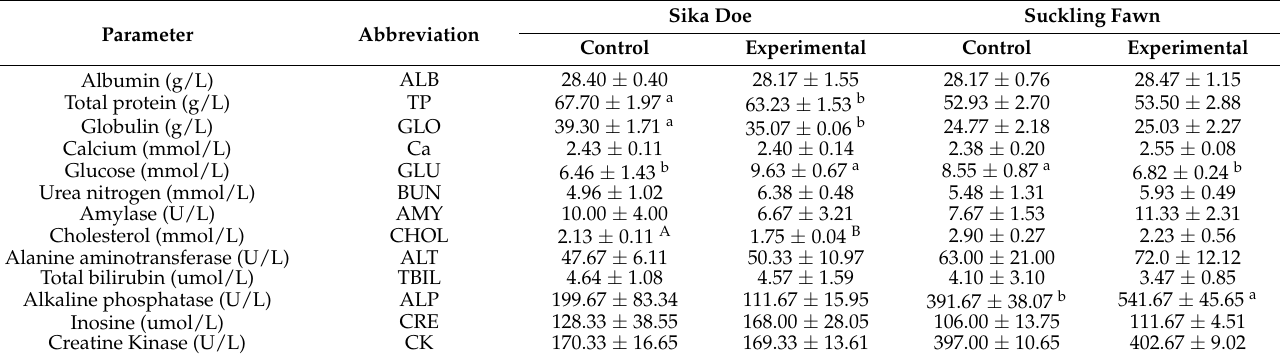
Table 4. Comparison of serum biochemical parameters of sika doe and suckling fawn.